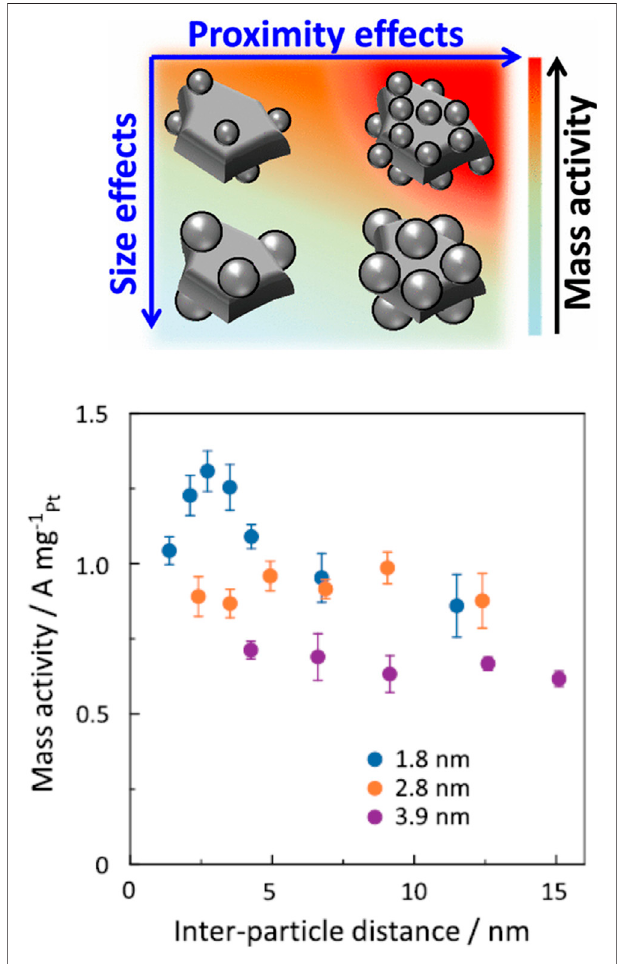
FIGURE 2 | ORR mass activity at 0.9 V versus the relative hydrogen electrode for Pt NPs supported on carbon with various Pt sizes and loadings and so different inter-particle distances. Reproduced with permission from (Inaba et al., 2021) Copyright 2021 American Chemical Society.